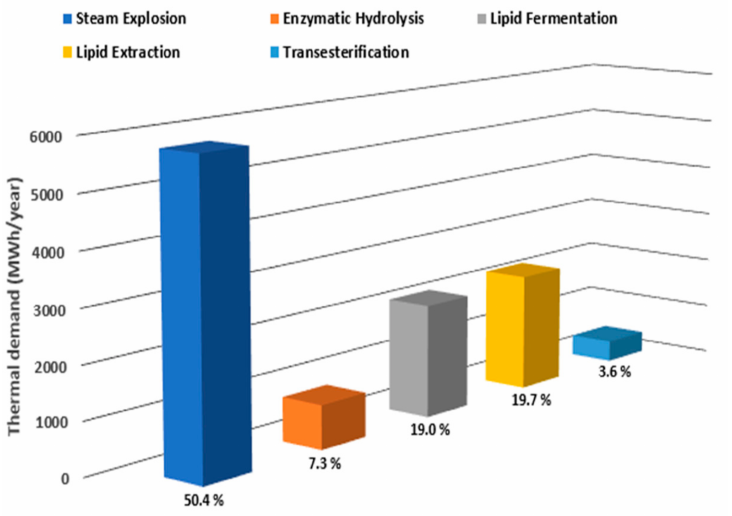
Figure 7. Distribution of thermal needs expressed in MWh/y and considering an operating period of 8000